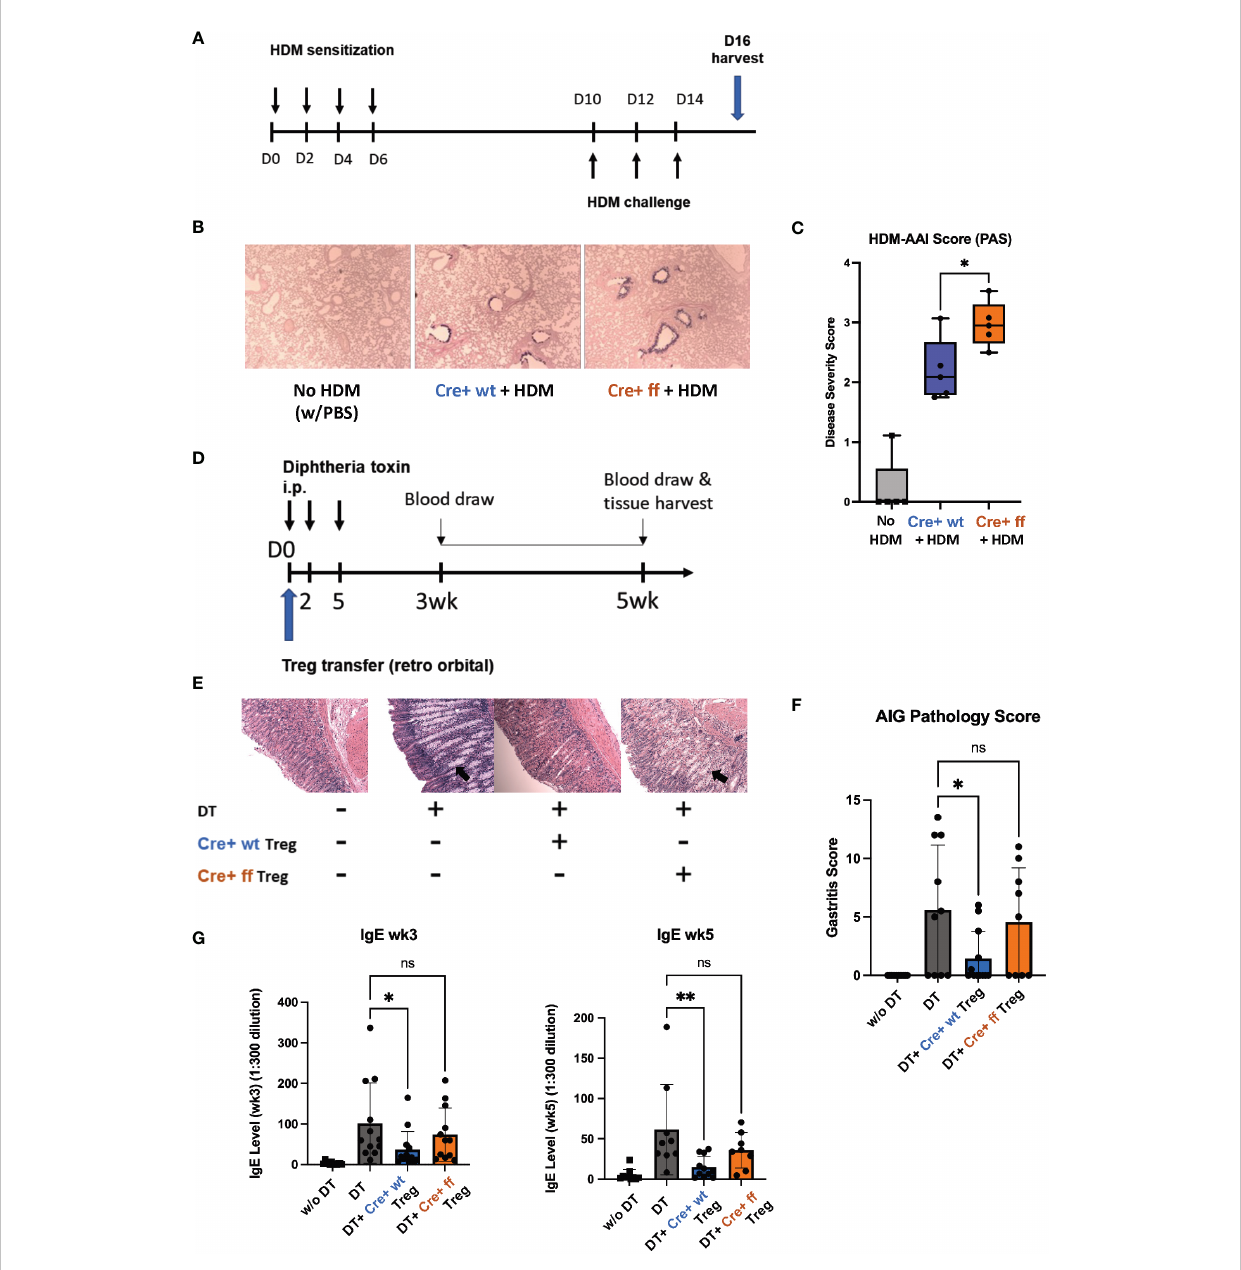
FIGURE 7 SHP-1 is required for the suppressive functionality of Treg cells in vivo. (A) Schematic diagram depicts HDM-AAI experimental setup. (B) Representative images of lung histology (PAS/Alcian blue staining) of Foxp3 Cre+ control and Foxp3 Cre+ Shp-1 f/f mice 5 weeks after HDM or PBS treatment. Magni fi cation: 4x (C) HDM-induced AAI disease severity represented by score based on PAS stained mucous. n= 6 ( Foxp3 Cre+ control), 6 ( Foxp3 Cre+ Shp-1 f/f mutant), 5 (PBS treated no HDM), (D) Schematic diagram of DEREG model. Treg cells are depleted by consecutive Diphtheria toxin (DT) injections causing an AIG phenotype that can be rescued via adoptive transfer of Treg cells. (E) Representative images of stomach histology (H&E staining) of indicated experimental groups. Magni fi cation: 10X. Arrows indicate epithelia hyperplasia/metaplasia. (F) AIG disease severity score based on H&E and PAS-stained histology images. n= 12 (no DT), 10 (DT), 12 ( Foxp3 Cre+ control), 9 ( Foxp3 Cre+ Shp-1 f /f mutant). ns = not signi fi cant. (G) Serum IgE level of the indicated experimental groups at 3 and 5 wks. Data are from three independent experiments with 2-3 mice per experimental group for each experiment. *, p<0.05, **, p<0.01. One-way ANOVA, followed by Fisher ’ s LSD test (C , G) , or Brown-Forsythe and Welch ANOVA test followed by Welch test (F) for multiple comparisons. ns, not signi fi